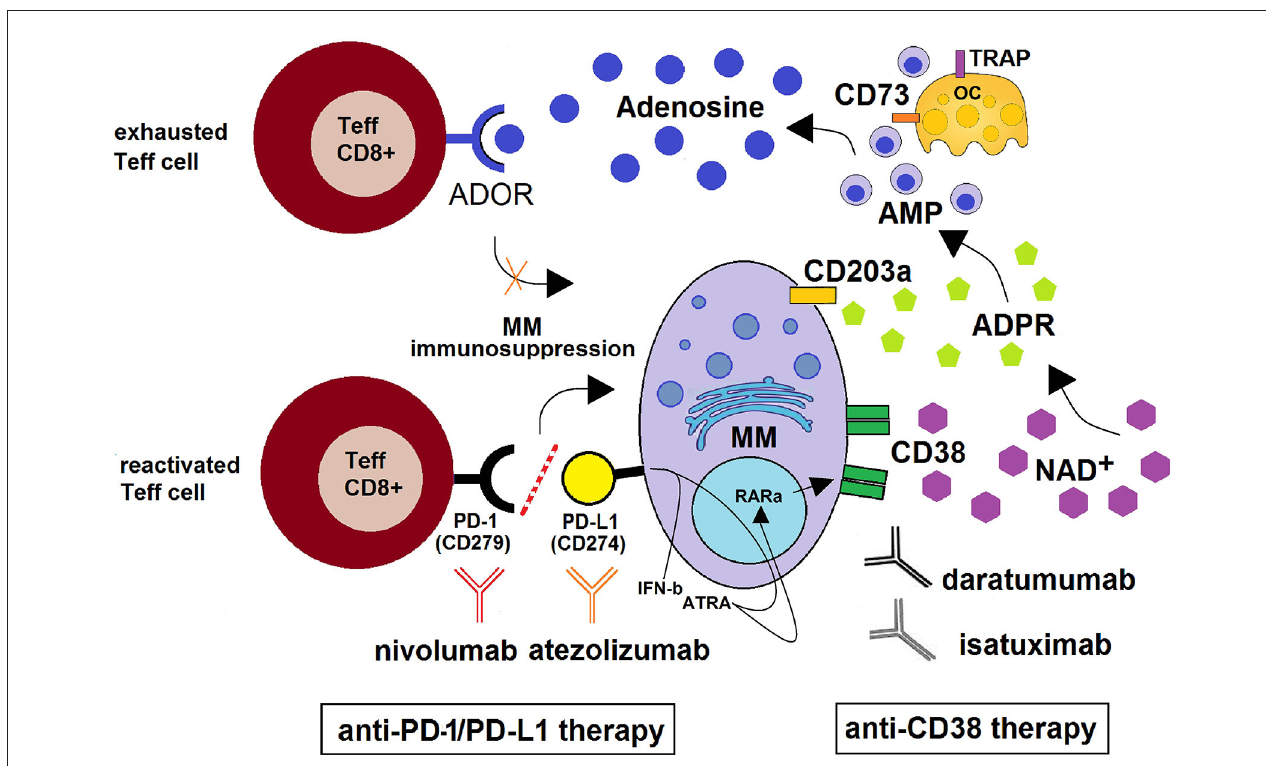
FIGURE 3 | Schematic depiction of the CD38/CD203a/CD73 adenosinergic pathway as a major mechanism of the acquired resistance to anti-PD-1/PD-L1 blockade within the BM niche. CD38 + high MM cells catalyze NAD + transformation to ADO via the CD38/CD203a/CD73 ectoenzymatic pathway, discontinuously expressed by BM resident cells (MM, OCs, OBs, BMSC). This step is followed by (i) the activation of the ADOR A2A and A2B on cytotoxic T-lymphocytes, with suppression of their anti-tumor functions and (ii) the induction of an anti-PD-1/PD-L1-mediated resistance to the increase of cytotoxic T-cell infiltration in the BM niche. Anti–PD-1/PD-L1-resistant MM cells also produce soluble mediators (such as IFN- β and ATRA) leading to increased expression of CD38 on mPCs via RAR α . This mechanism support the use of anti-CD38 mAbs (e.g., daratumumab and isatuximab) with the ability to inhibit CD38 cyclase activity. When used in combination with PD-1/PD-L1 immune checkpoint blockade (e.g., nivolumab and atezolizumab), the result may be an improvement of antitumor immune responses with reactivation of CD8 + T effector lymphocytes leading to a control of MM